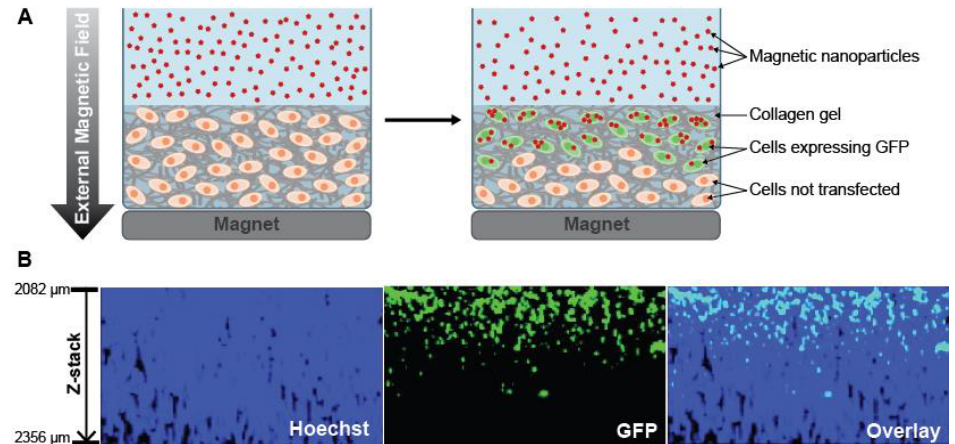
Figure 4. ( A ) Schematic representation of gene delivery by magnetic nanoparticles to 3D cell cultures seeded in a collagen matrix. ( B ) Z-stack image of 3D cell culture transfected with polyethyleneimine-coated superparamagnetic nanoparticles loaded with green fluorescent protein plasmid (PEI-coated SPMN/GFP) plasmid complexes for 3 h. Hoechst is shown in blue (first panel) while GFP transfected cells in green (second panel). Left hand scale: distance from the top of the culture. Adapted from Reference [90], with permission from American Chemical Society © 2020.